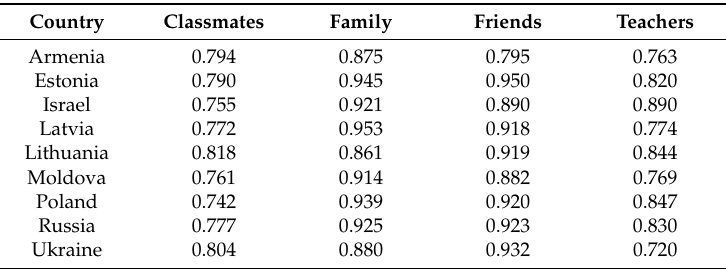
Table 2. Internal consistency of support scales by country (Cronbach alphas).